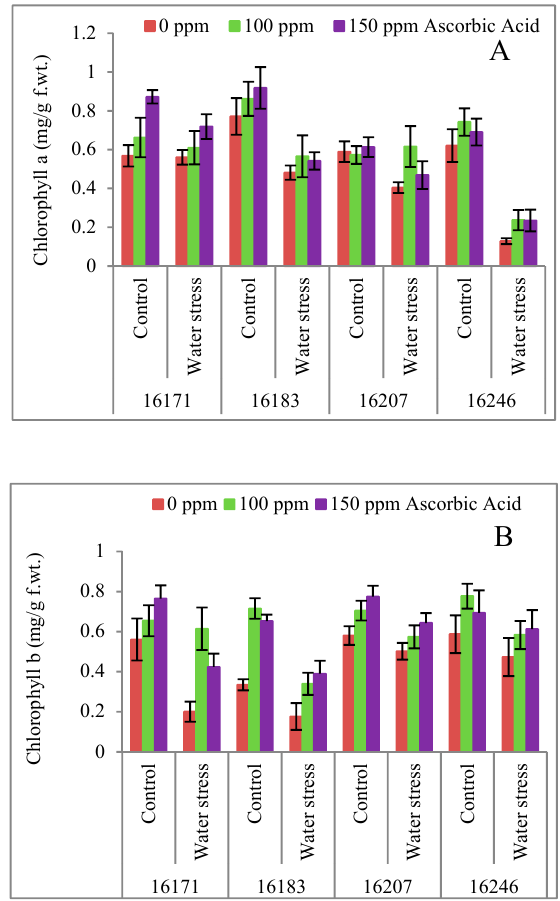
Figure 2. Chlorophyll a ( A ), chlorophyll b ( B ) contents of four cultivars of safflower ( Carthamus tinctorius L.) foliarly treated with ascorbic acid subjected to water stress conditions (mean ± S.E.). Proline concentration increased (9.3–9.8%) significantly ( p ≤ 0.05) in safflower cvs. 16171 and 16246 upon exposure to water deficit conditions. Exogenously applied AsA particularly the 150 mg/L concentration significantly ( p ≤ 0.001) improved (76.0–93.5%) the proline content in all four cultivars under varying water regimes (Table 1; Figure 3A). All four safflower cultivars were similar in proline accumulation under water deficit conditions and foliar applied AsA.